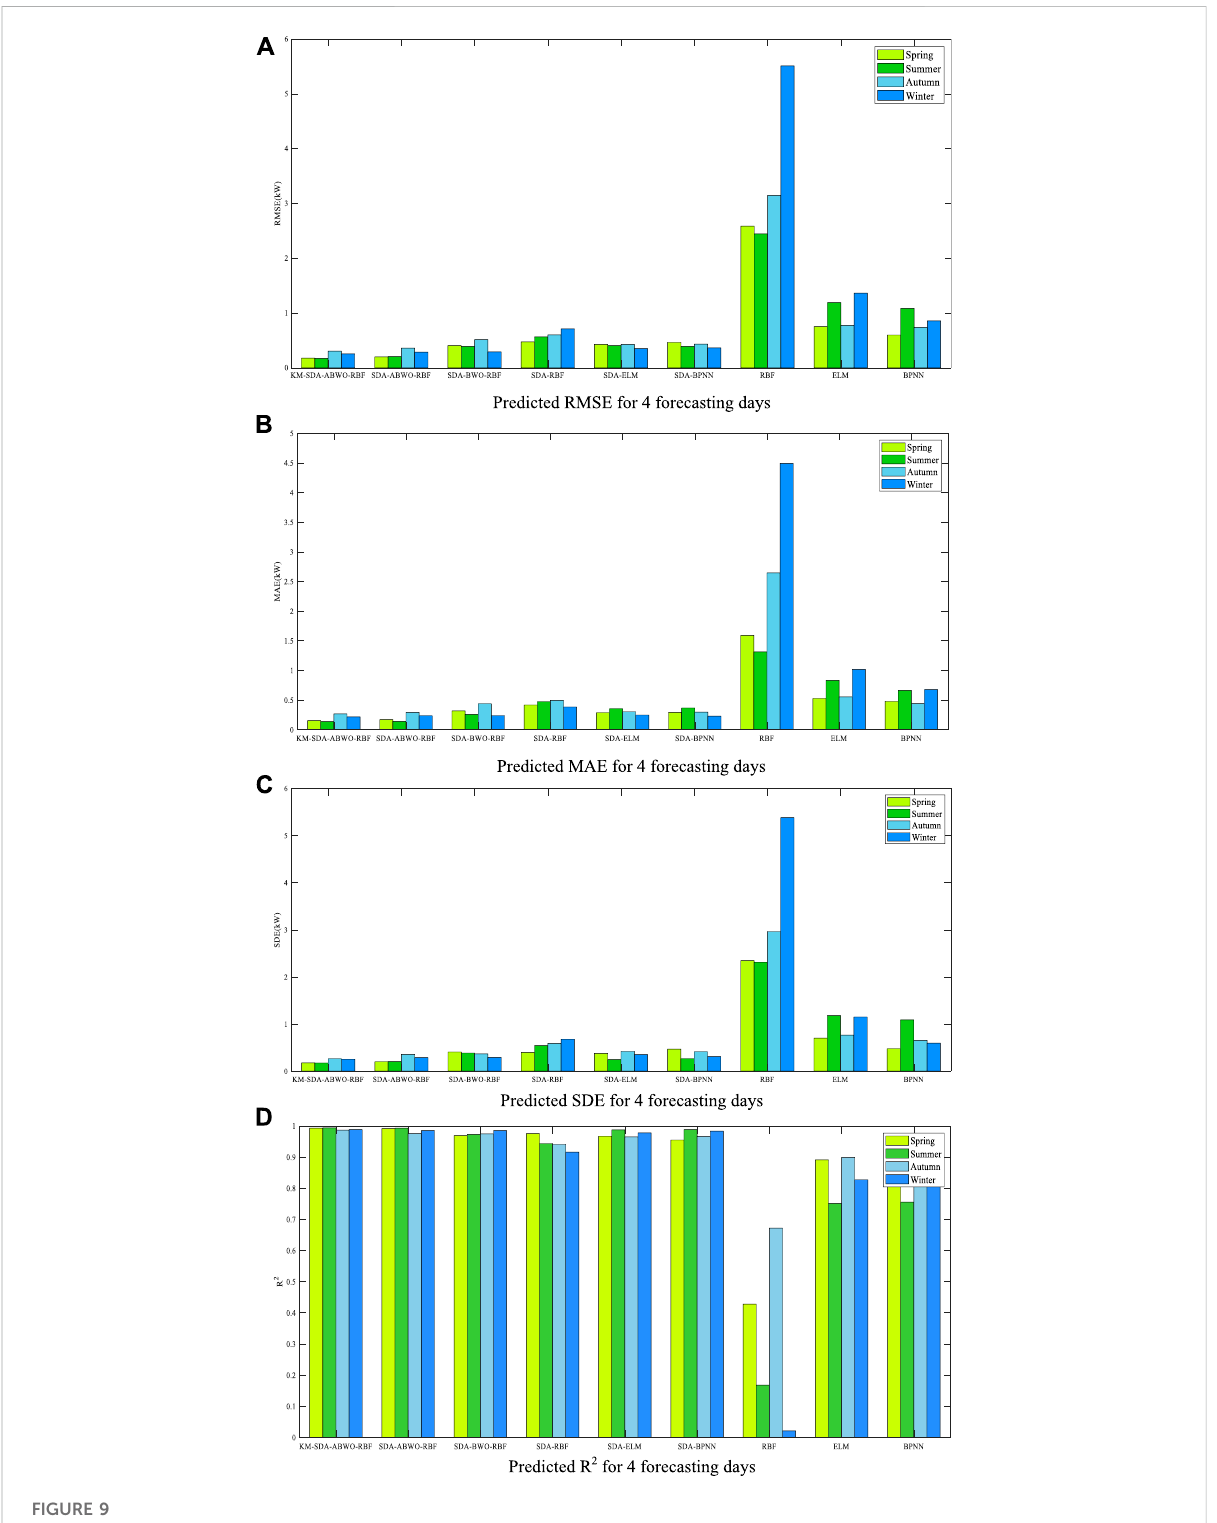
FIGURE 9 Predicted (A) RMSE. (B) MAE. (C) SDE. (D) R 2 for 4 forecasting